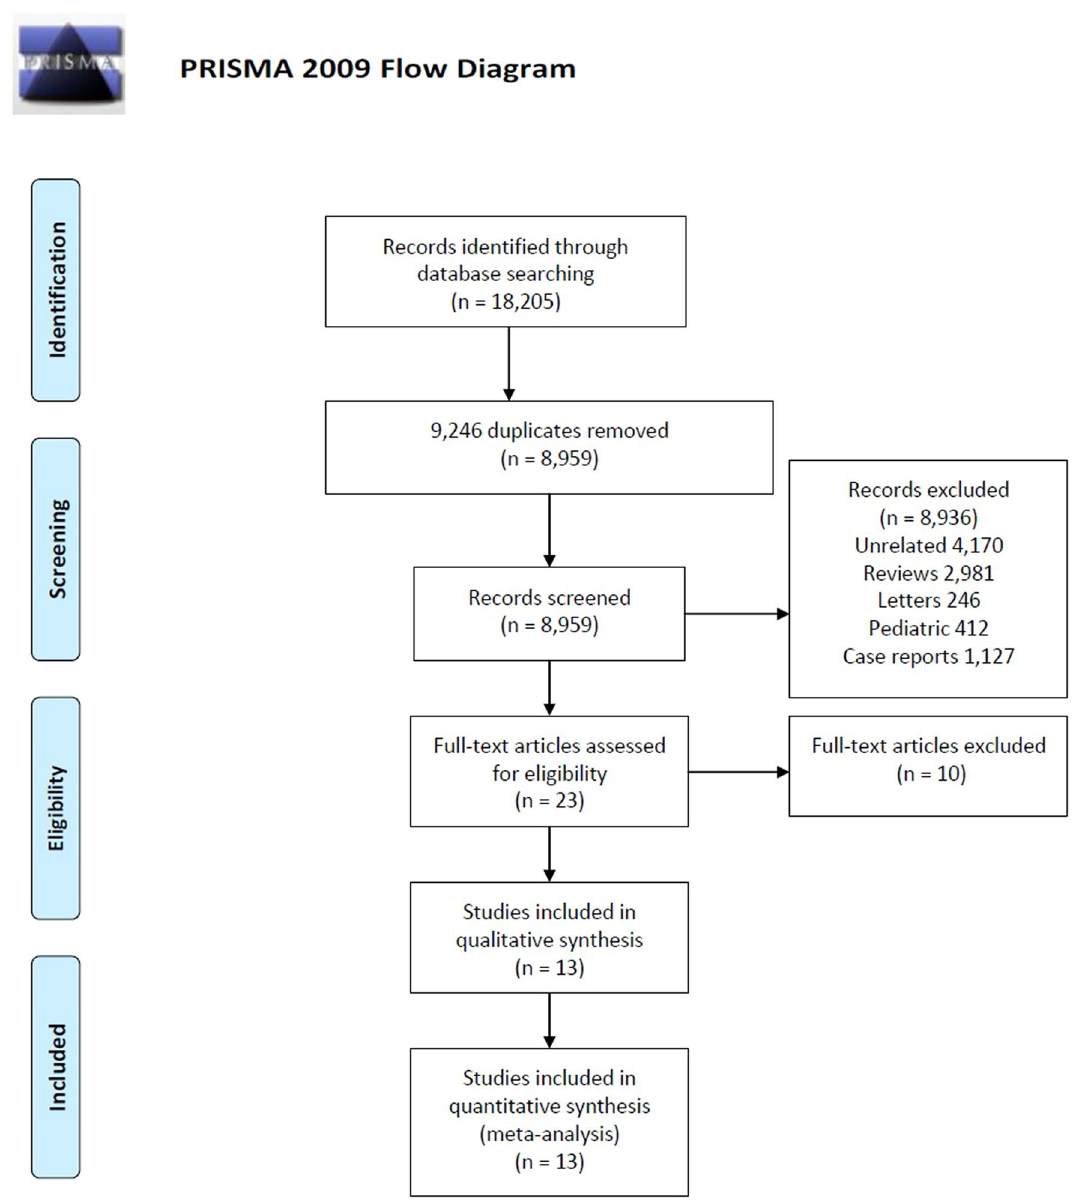
Figure 1. PRISMA flow-chart depicting search strategy used for conducting this